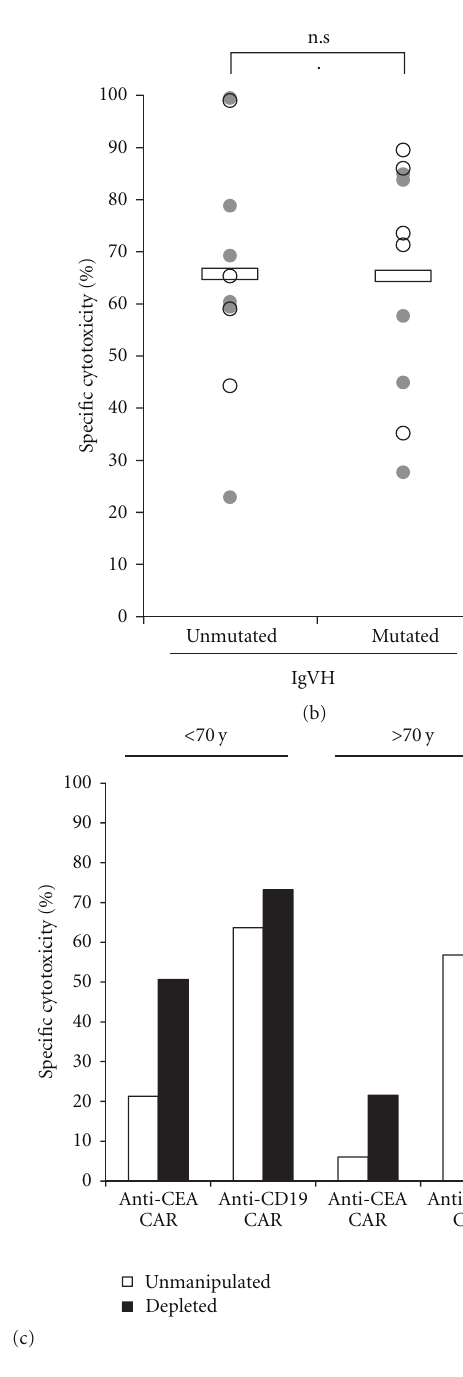
Figure 3: ZAP70-positive B-CLL cells are more e ffi ciently eliminated by CAR-redirected T cells in vitro. The e ffi cacy in specific cytolysis by CAR-redirected T cells (data from Figure 1(d)) was plotted against (a) serum thymidine kinase-1 levels ( < 10U/L versus > 10U/L), (b) mutated versus unmutated status of the immunoglobulin heavy chain variable region of B-CLL cells, and (c) patient’s age ( < 70yrs versus > 70yrs). Closed circles represent CD3 ζ CAR, open circles CD28-CD3 ζ CAR-mediated B-CLL killing. Depletion from CD25 high Treg cells improves redirected cytolysis of B-CLL cells as exemplarily shown for two patients. Statistic calculations were performed using Student’s t -test, ∗ P < 0 . 05; ∗∗ P < 0 .